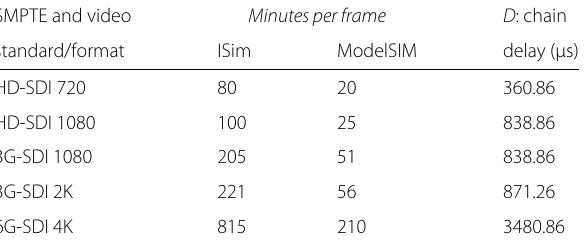
Table 2 Simulation time execution and chain delay comparison for several SMPTE standards and video formats in ISIM and ModelSIM